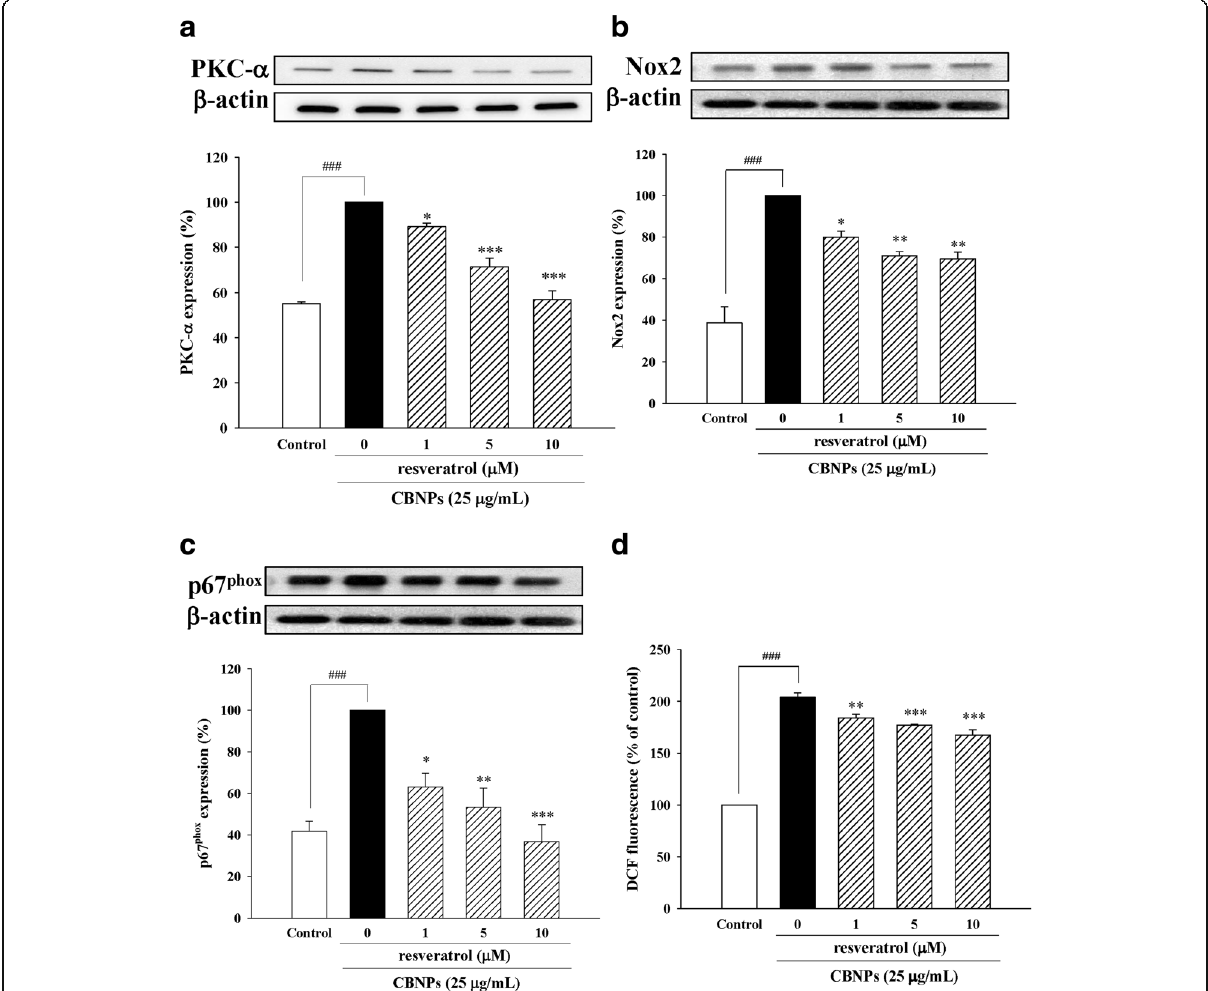
Fig. 8 Effects of resveratrol on PKC- α expression ( a ), Nox2 expression ( b ), p67 phox membrane translocation ( c ), and ROS production ( d ) in CBNPs-treated A549 cells. Cells were pretreated with resveratrol for 1 h before addition of CBNPs (25 μ g/mL) for 24 h. ROS production was measured using H 2 DCF-DA staining and detected the DCF fluorescence by flow cytometer. Bars represent the mean±S.E.M. from six independent experiments. ### P <0.001 vs. control group (without any treatment). * P <0.05, ** P <0.01, *** P <0.001 vs. CBNPs (25 μ g/mL)